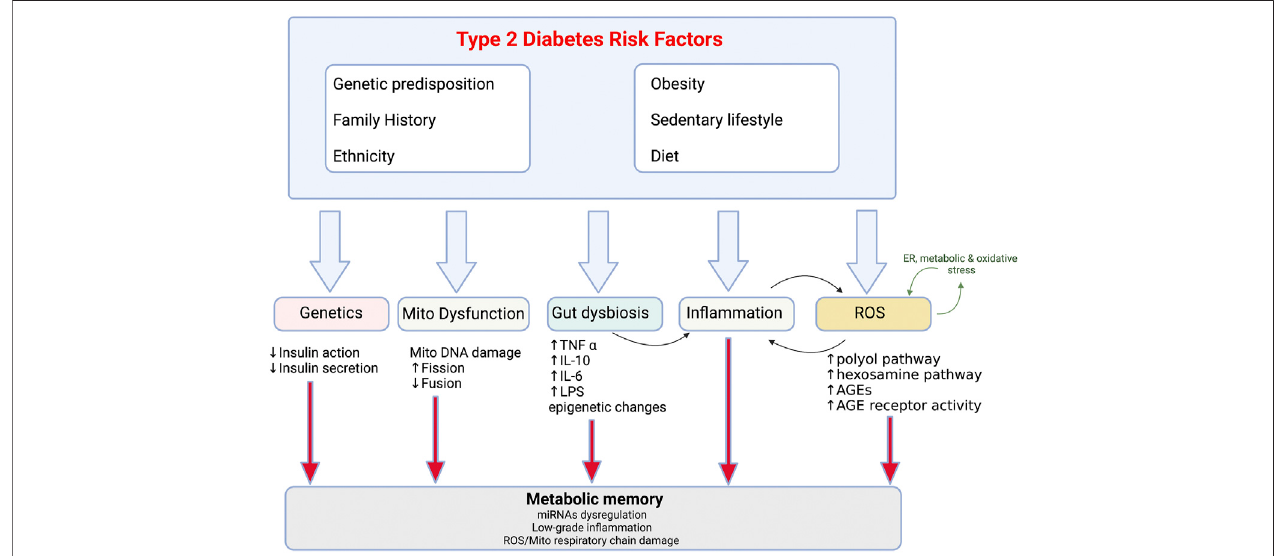
FIGURE 1 | Risk factors and pathophysiological changes in type 2 diabetes Combination of the modi fi able (obesity, sedentary lifestyle, diet) and non-modi fi able (genetics, ethnicity, family history) risk factors and resultant pathological changes which drive reduction in insulin sensitivity in T2D. Mito-mitochondria, AGE-advanced glycated end products, ROS- reactive oxygen